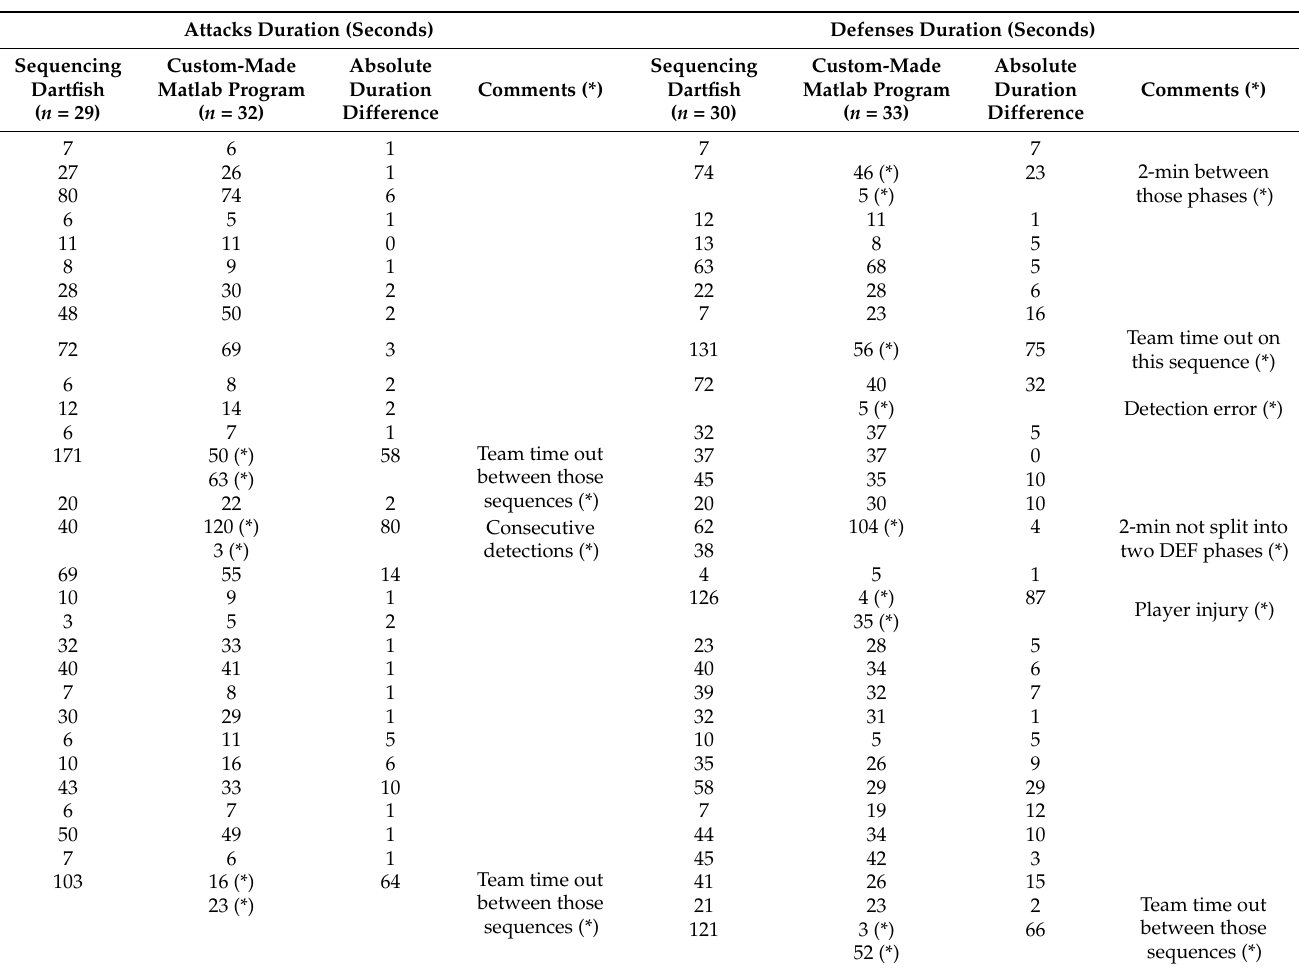
Table A2. Second half of the first match of the data validation set. Comparisons between Dartfish sequencing and the custom-made Matlab program.